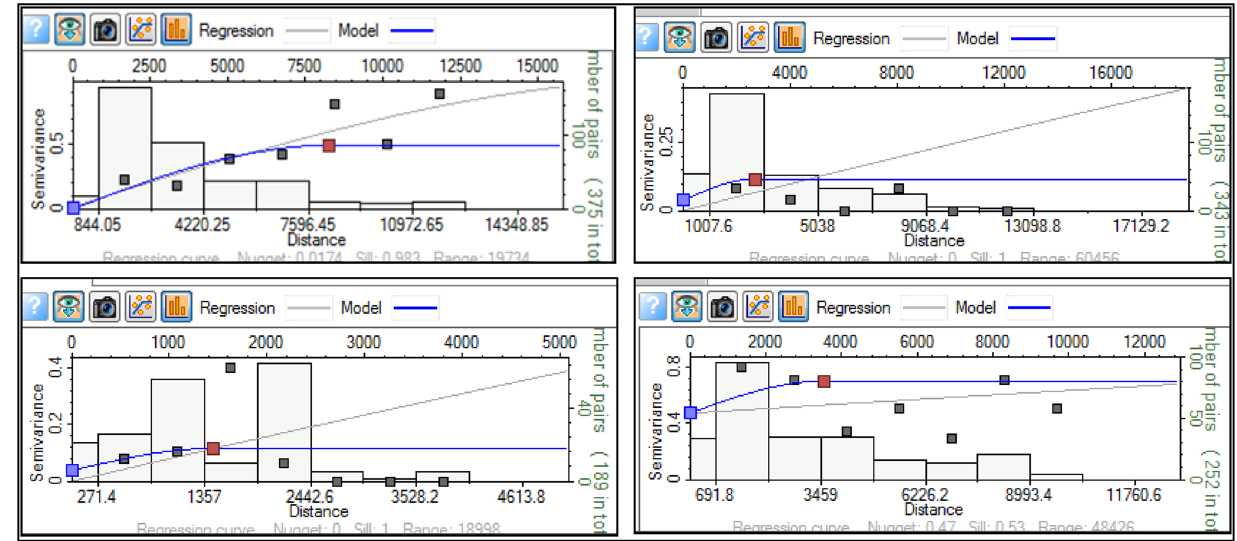
Fig. 9 Samples of semivariogram